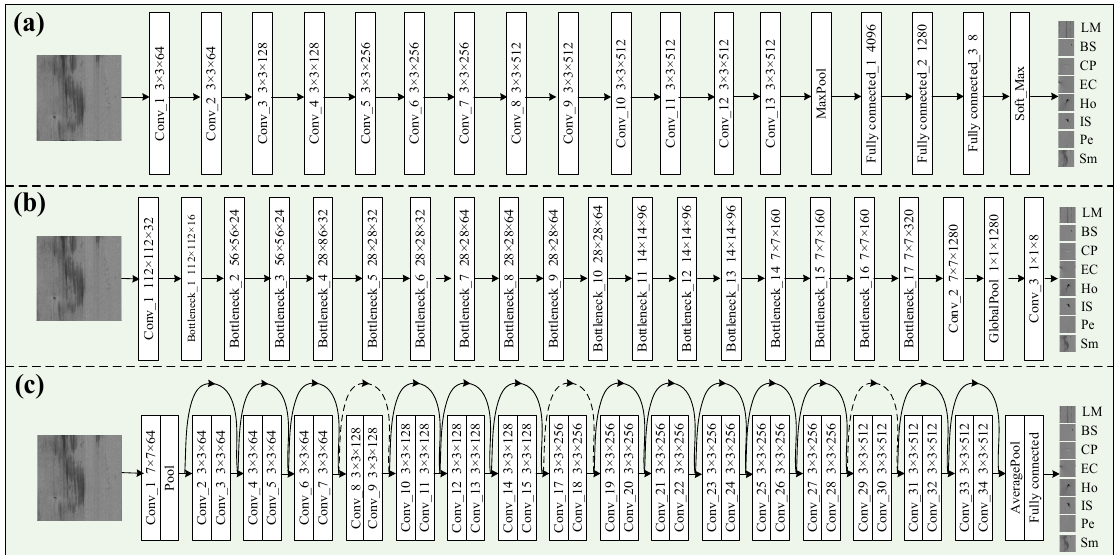
Figure 9. Recognition models are established by other three CNNs: ( a ) VGG16, ( b ) MobileNetV2, and ( c ) ResNet50.